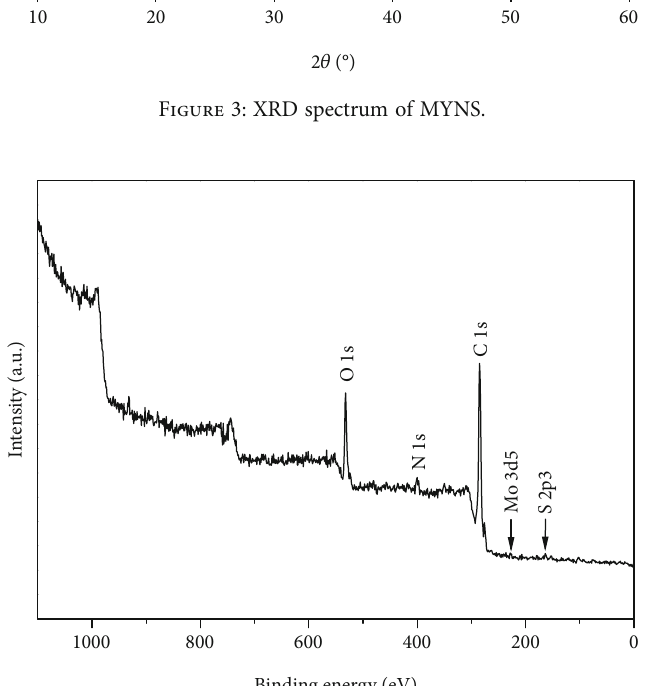
Figure 4: XPS spectrum of